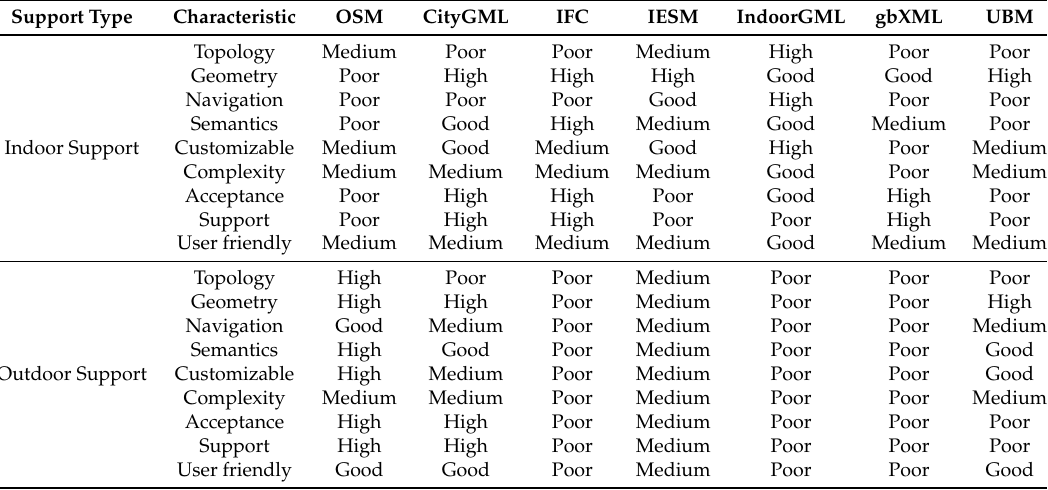
Table 1. Evaluation of the most representative indoor and outdoor properties of the main standards and works. CityGML: City Geography Markup Language; gbXML: Green Building XML; IESM: Indoor Emergency Spatial Model; IFC: Industry Foundation Classes; OSM: OpenStreetMap; UBM: Unified Building